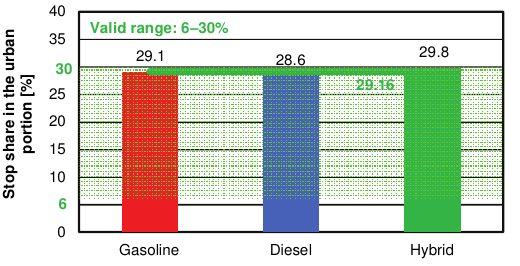
Fig. 11. Share of time spent stationary for the urban portion of the drive test with the limit values (required) and mean values for all vehicles